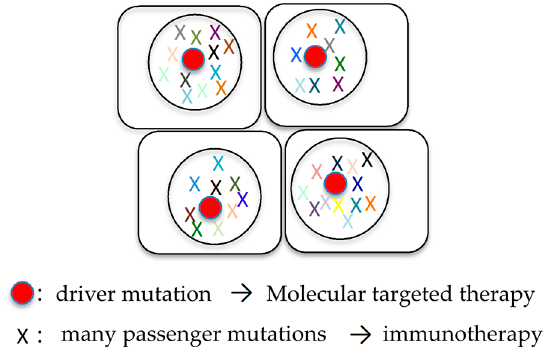
Figure 4. Combination of molecular targeted therapy and immunotherapy. Cancer cells harbor many mutations, typically single driver mutation and many passenger mutations in lung cancer. Driver and passenger mutations can become the therapeutic target for molecular targeted therapy and immunotherapy, respectively.